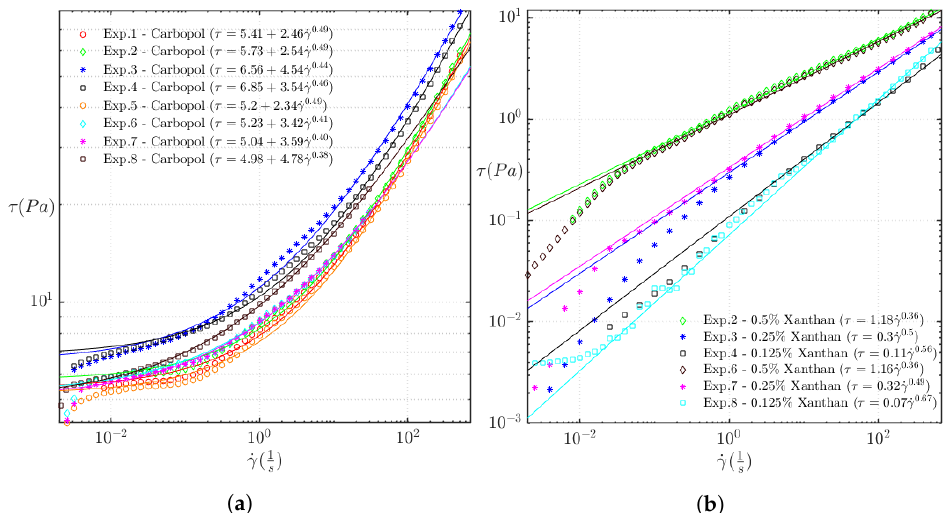
Figure 3. Shear rheology data of ( a ) Carbopol and ( b ) xanthan (fitted model coefficients are reported in Table 2).